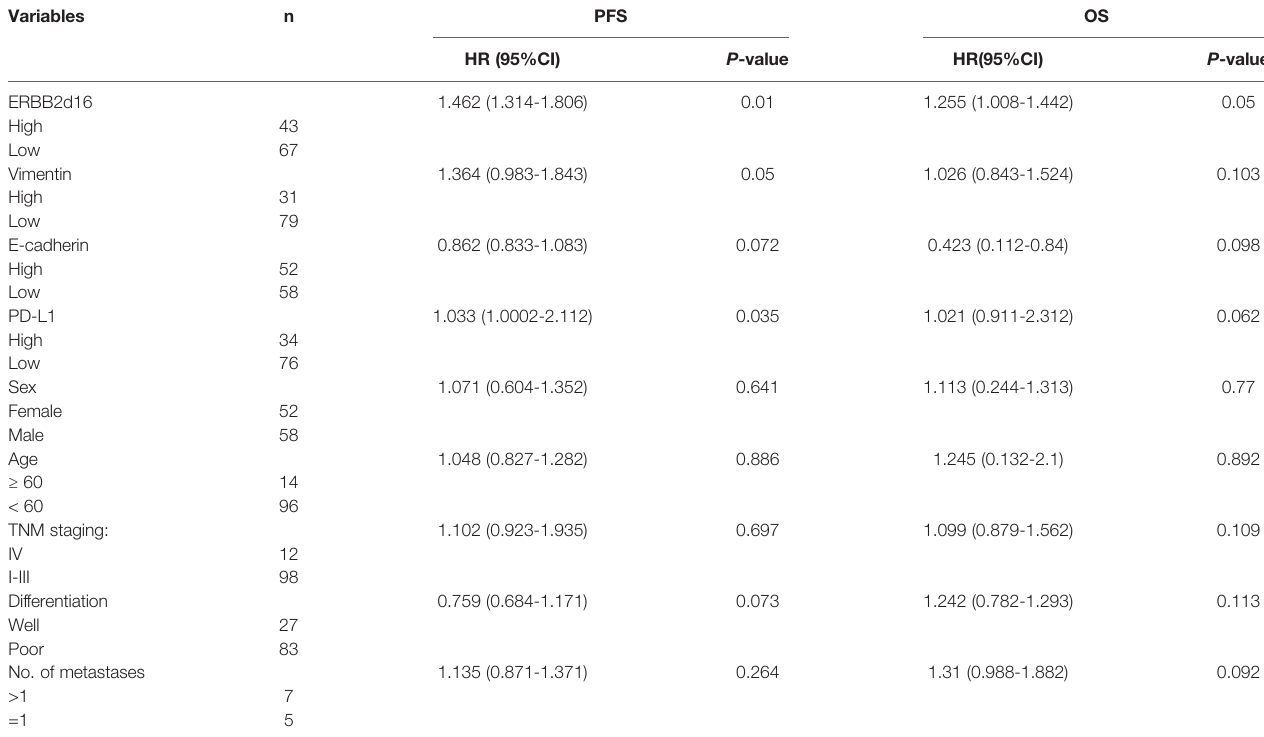
TABLE 3 | Multivariable Cox proportional hazard regression analysis of patients ’ demographic and clinical characteristics and survival (n = 110).